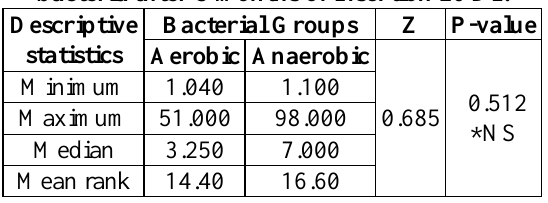
Table 3: Descriptive and statistical test of viable count between aerobic and anaerobic bacteria after 3 months of insertion 20 DI.